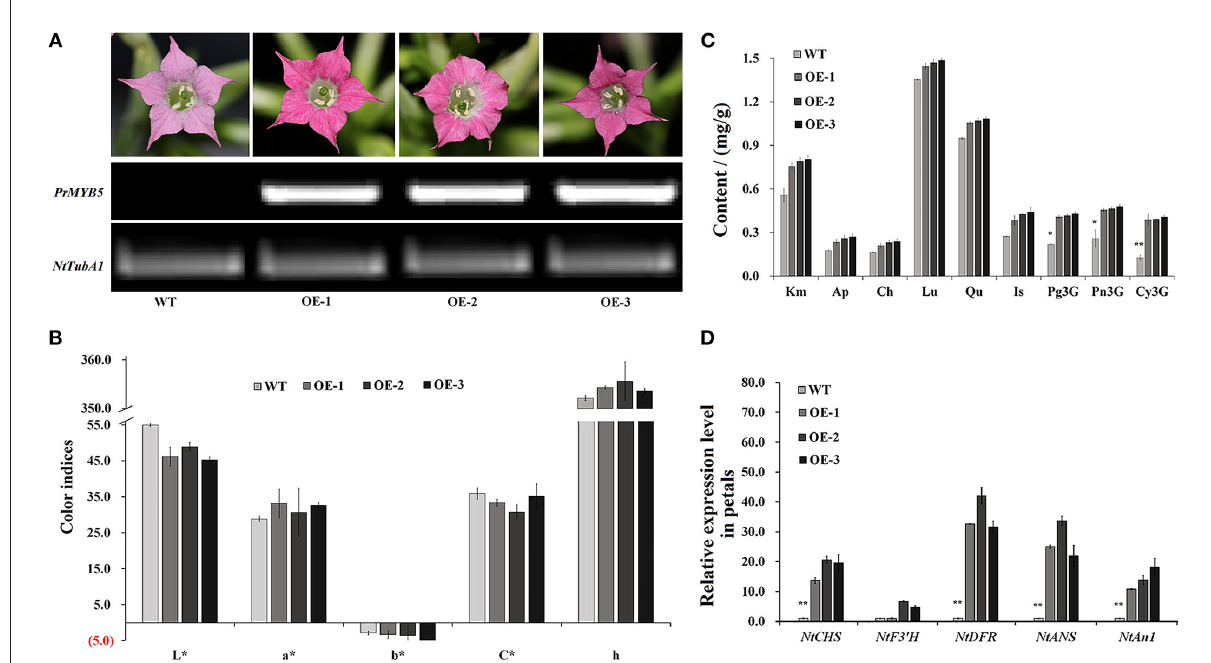
FIGURE5 Overexpression of PrMYB5 promotes the accumulation of anthocyanins in tobacco. (A) Flower phenotypes of OE-lines (OE-1, 2, and 3) and wild-type (WT) petals, and their corresponding PrMYB5 transcription levels. NtTubA1 was used as an endogenous control. (B) The color indices in OE-lines and wild-type petals. L * represents the lightness. a * represents the redness. b * represents the yellowness. C * represents chroma. h represents the hue angle. (C) The contents of pigments in OE-lines and wild-type petals. (D) Expression profiles of PrMYB5 and structural genes in OE-lines petals by qRT-PCR. * Indicates significant differences at P < 0.05; ** indicates relatively significant differences at P <